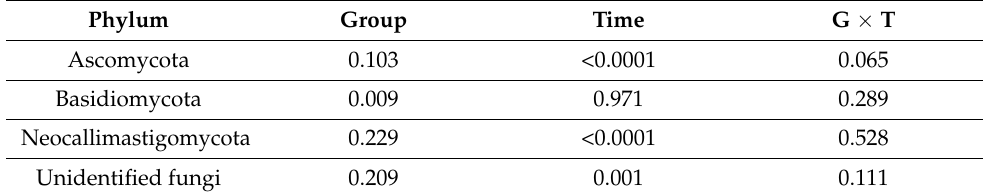
Figure 7. Relative abundance (%) of fungi in the ruminal samples from the control and SC groups ( n = 6 per group) at BS, Pa and PP. Table 8. p -values associated with the statistical analysis of the relative abundances of fungi phyla in the rumen. Only phyla with a relative abundance >1% were kept for statistical analysis.